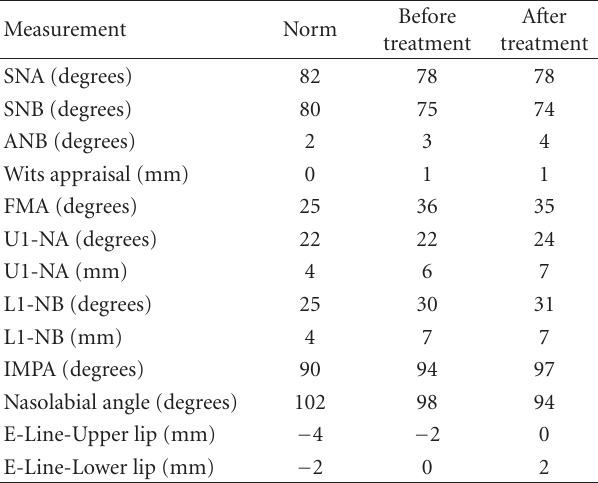
Table 1: Summary of cephalometric